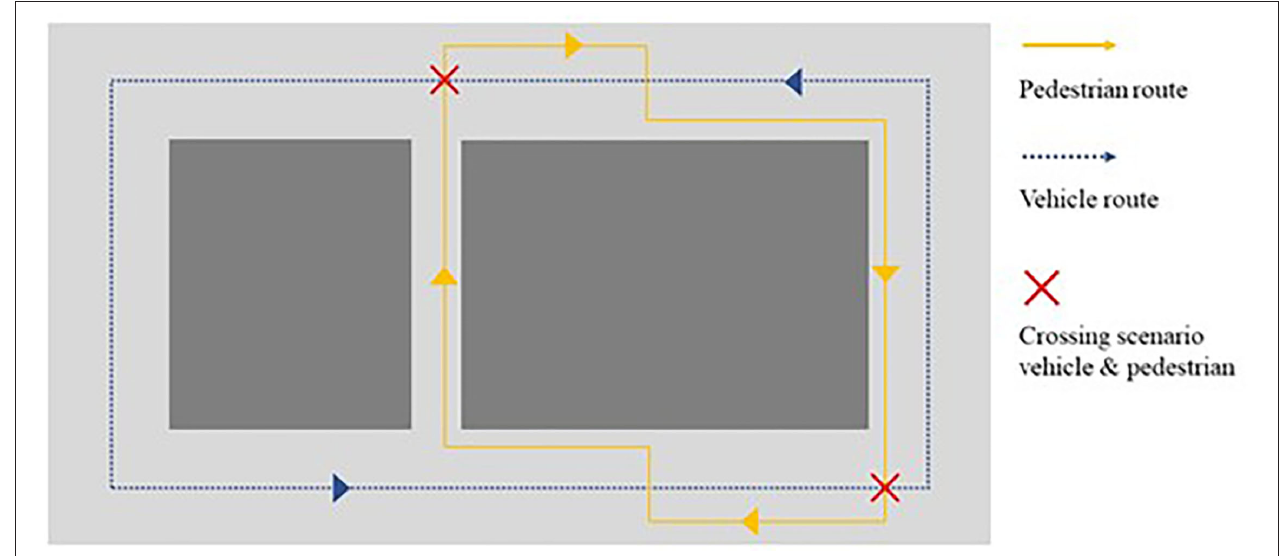
FIGURE 6 | Visualization of the test procedure with the predefined interaction points (red x ).